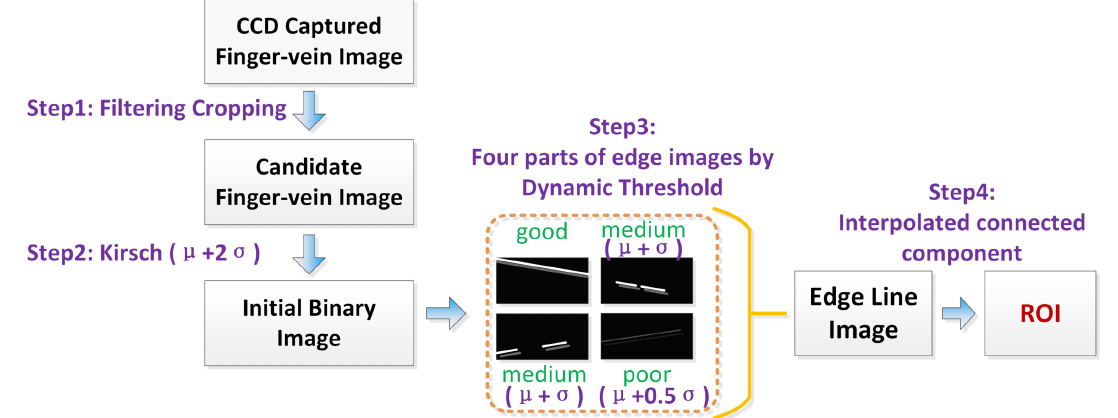
Figure 2. Flowchart of the newly proposed robust ROI localization method.